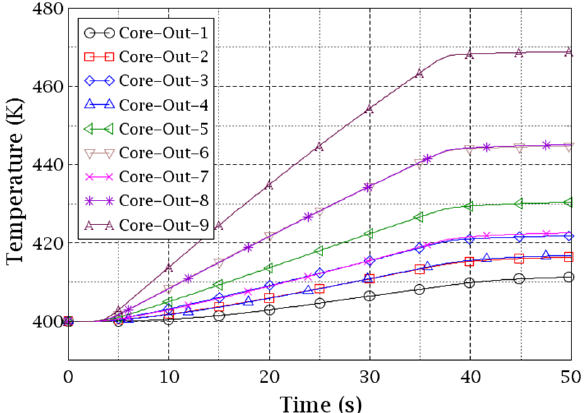
Figure 15. Evolution of the coolant temperature distribution at the core outlet CY-V (cell index is from Figure 10).